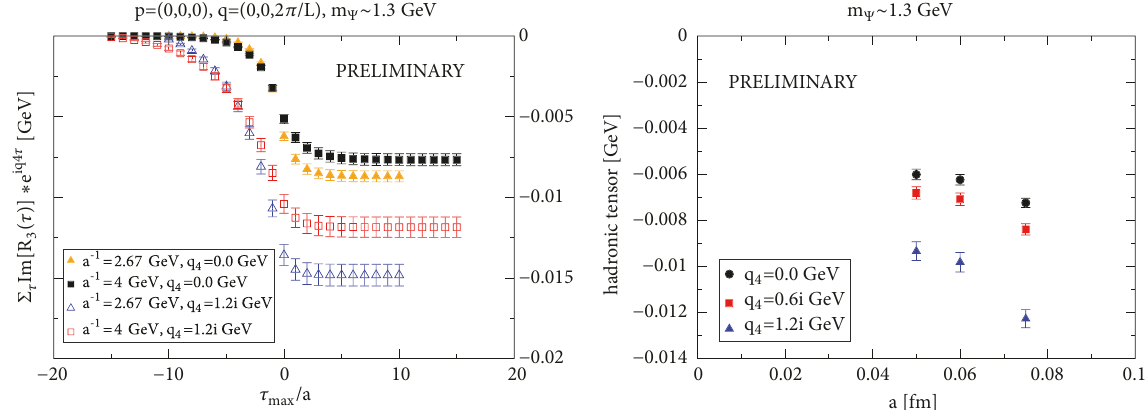
Figure 33: Left: integrand of 𝑈 [12] 𝐴 (𝑞,𝑝) for a pion at rest, momentum transfer (0,0,2𝜋/𝐿) , heavy quark mass of 1.3 GeV. Different sets of data points correspond to two lattice spacings and two values of 𝑞 4 . Right: imaginary part of 𝑈 [12] 𝐴 (𝑞, 𝑝) for three lattice spacings and three values of 𝑞 4 , other parameters the same as in the left plot. Source: [68] (arXiv), reprinted with permission by the